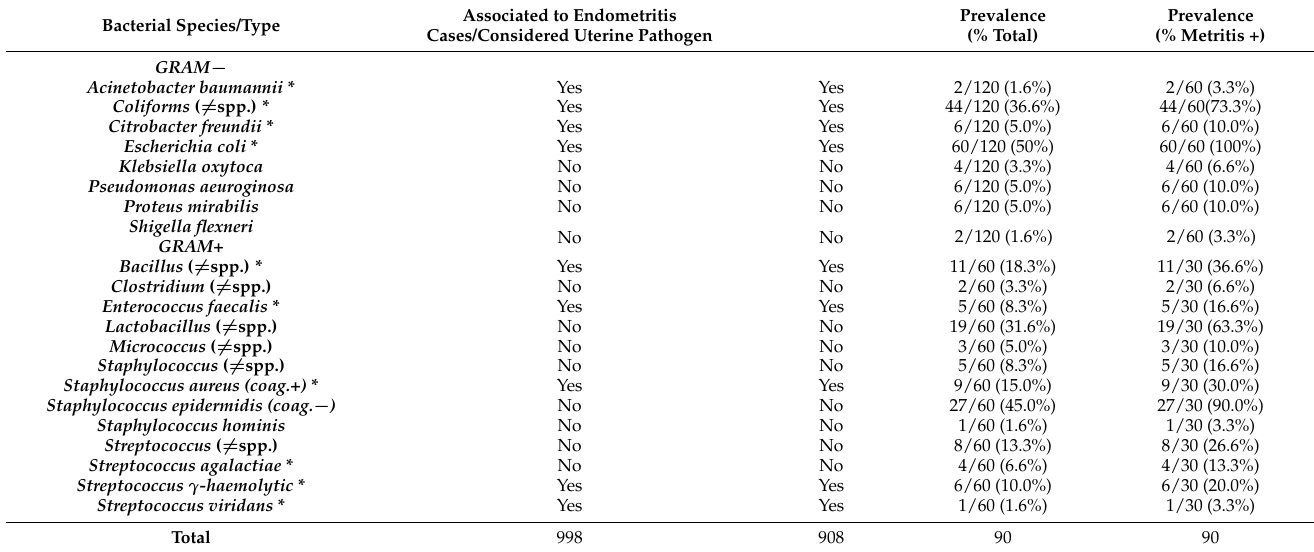
Table 4. Identification and classification of Gram-negative and Gram-positive bacteria obtained in in vitro cultures derived from intrauterine swab samples (Cytobrush) based on their potential pathogenicity in producing metritis in dairy cows naturally infected by E. coli during the early postpartum period.